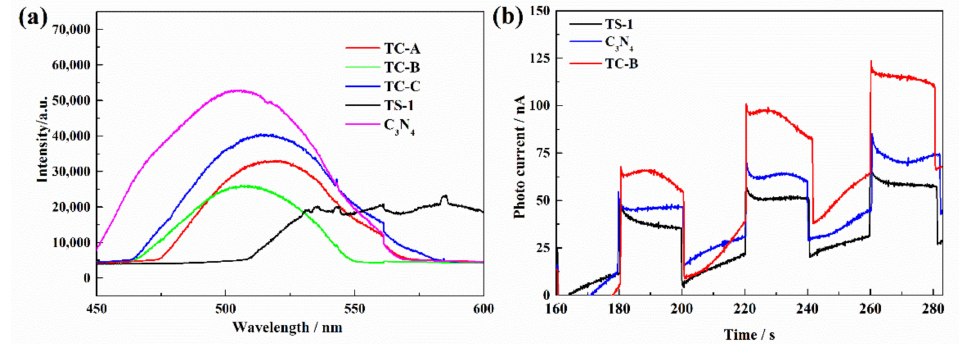
Figure 6. ( a ) PL spectra of all the materials. ( b ) The photocurrents of C 3 N 4 , TS and TC-B with light on / o ff cycles under visible light